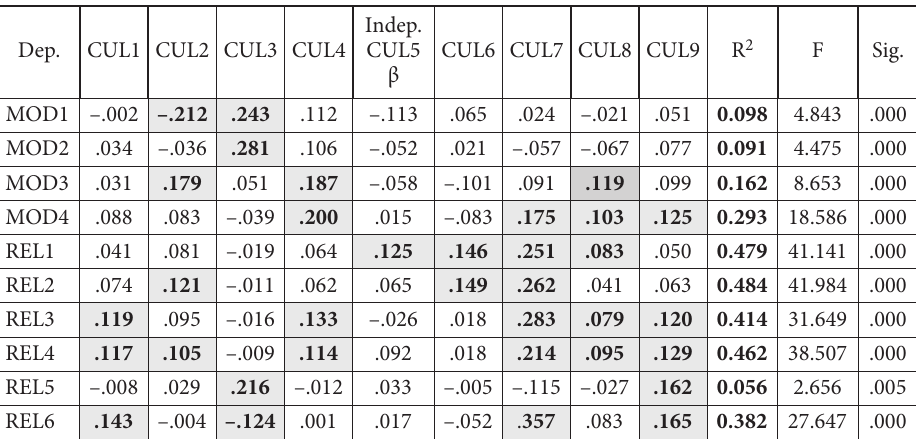
Table 3. Regression analysis (independent variables: the organizational culture dimensions; dependent variables: the CMPR dimensions and the OPR dimensions) Dep.